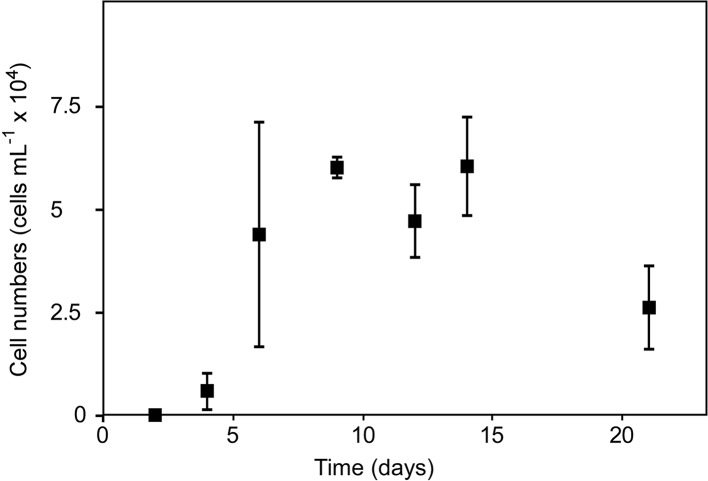
Exemplary growth curve of Pseudovibrio sp. FO-BEG1 in clean artificial seawater (medium 2, counted in triplicates).Cell numbers (squares) increased to 6×104 cells mL-1 after 1 week of incubation.